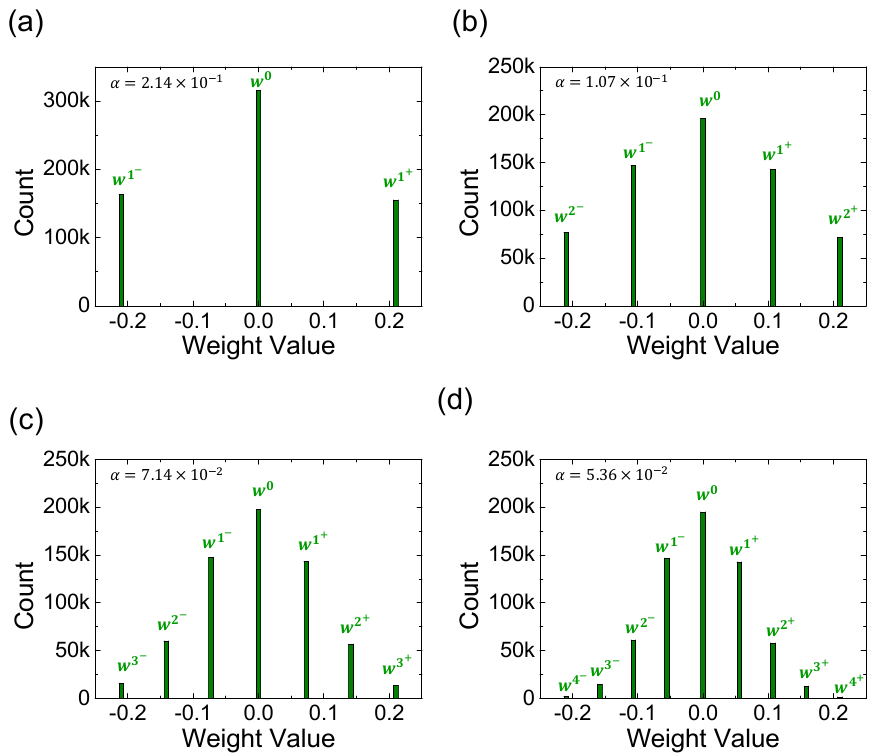
Figure 3. Weight distributions quantized by: ( a ) 3; ( b ) 5; ( c ) 7 and ( d ) 9-level, each of which is optimized by the interval α .